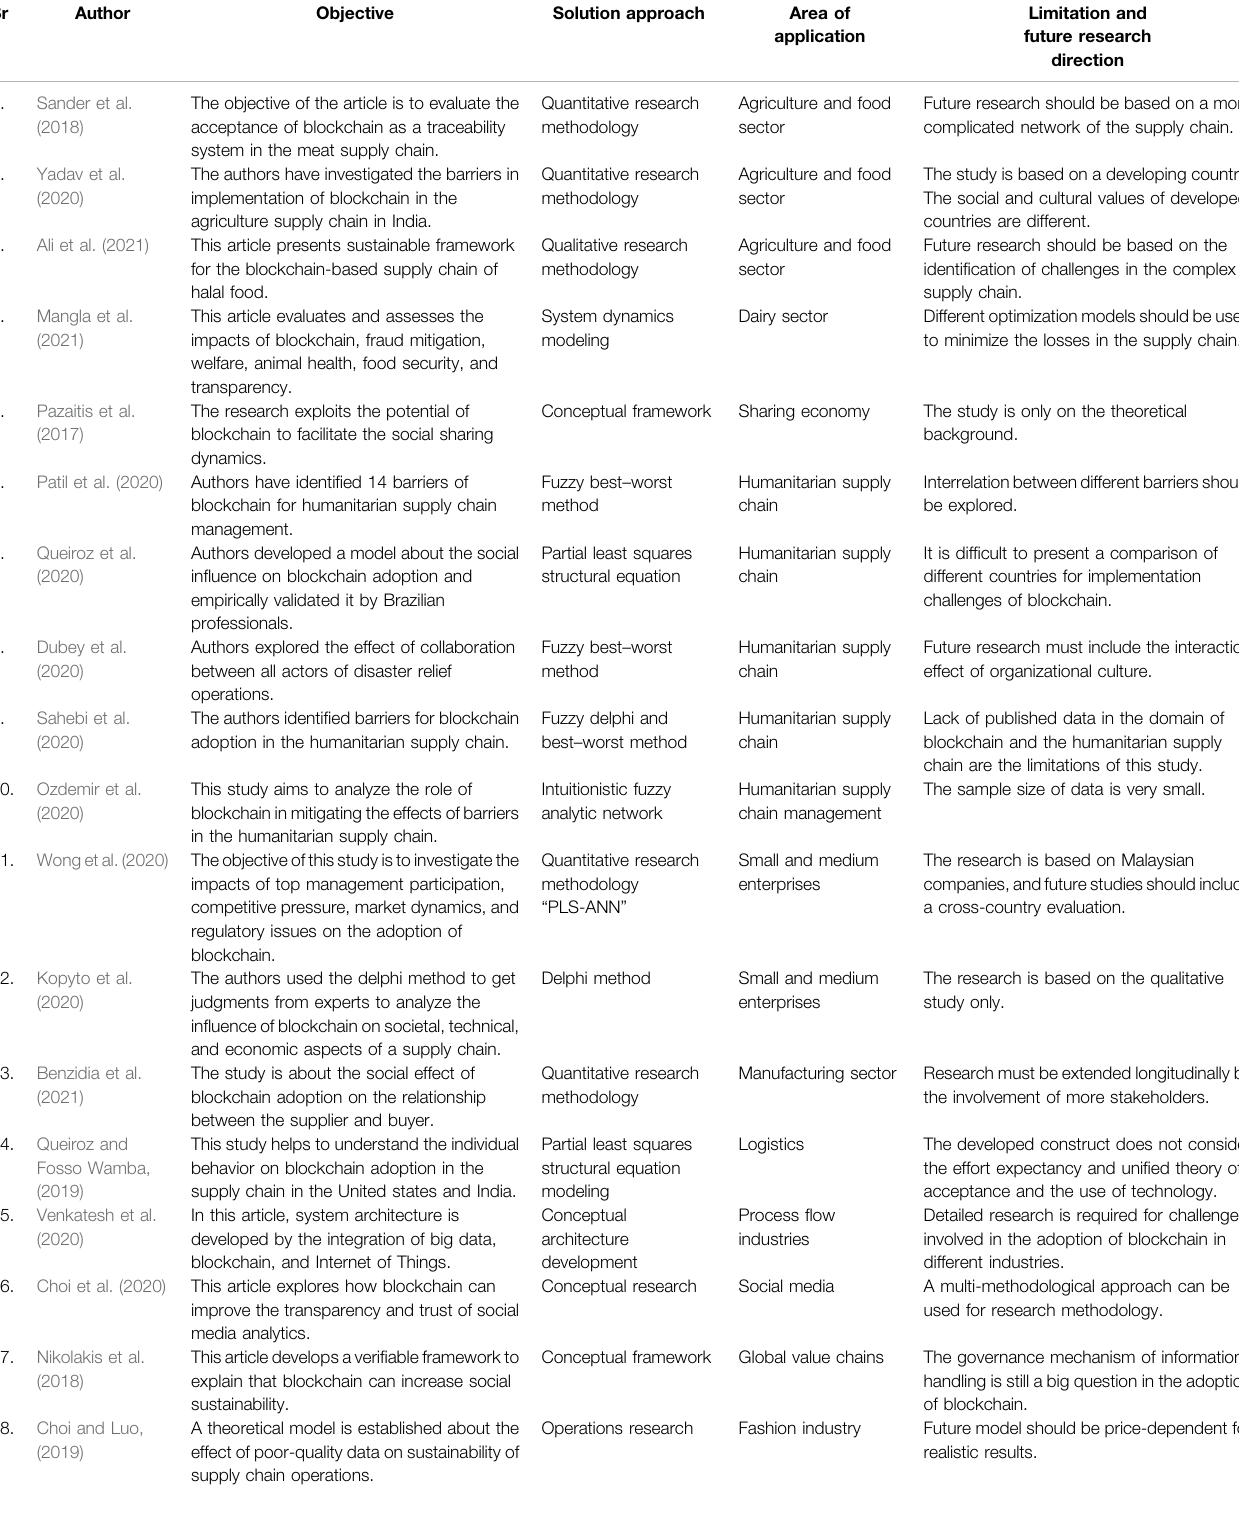
TABLE 9 | Article related to blockchain use for social sustainability in the supply chain and humanitarian supply